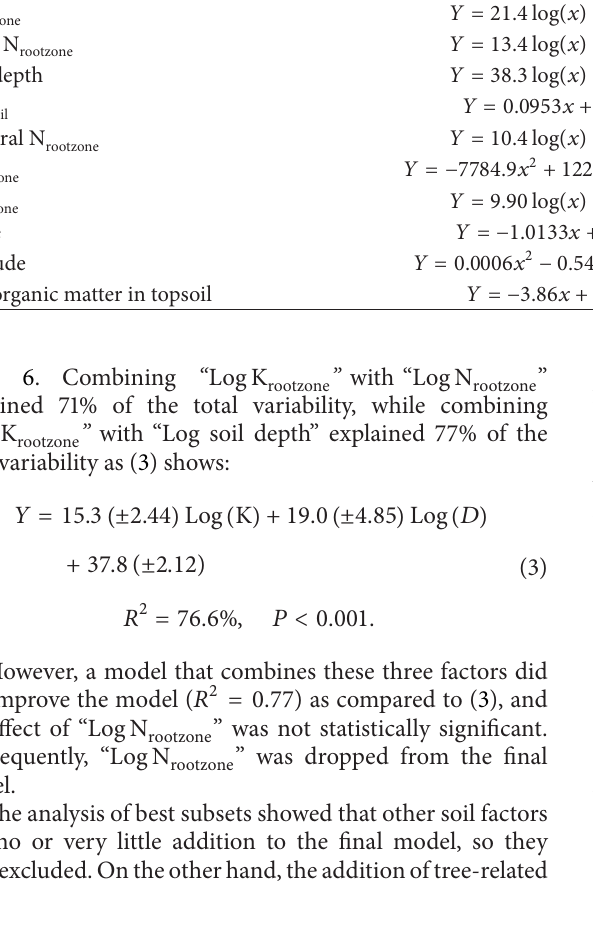
Table 4: Regressions between olive fruit yield (𝑌) and external factors (𝑥) . Coefficients of determination (𝑅 2 ) and statistical significance (𝑃) are also presented. Models are sorted in descending order of 𝑅 2 . Yield vs. parameters